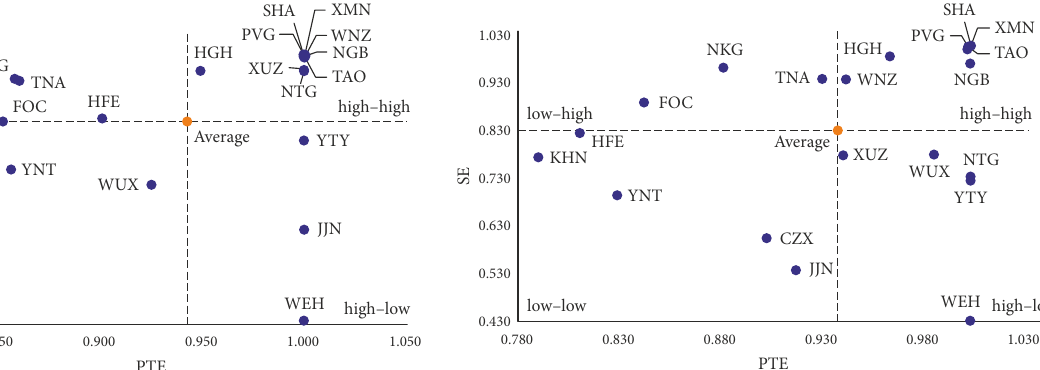
Figure 6. Categorizations of PTE and SE of 20 airports in the first stage